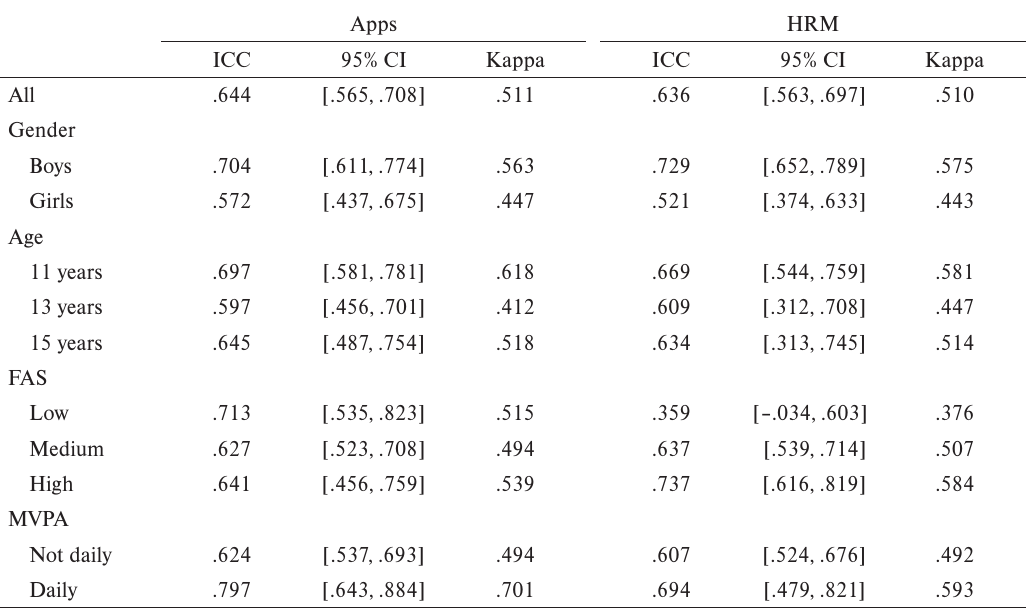
Intraclass correlation coefficient and Cohen’s Kappa of physical activity tracker items for each variable Apps